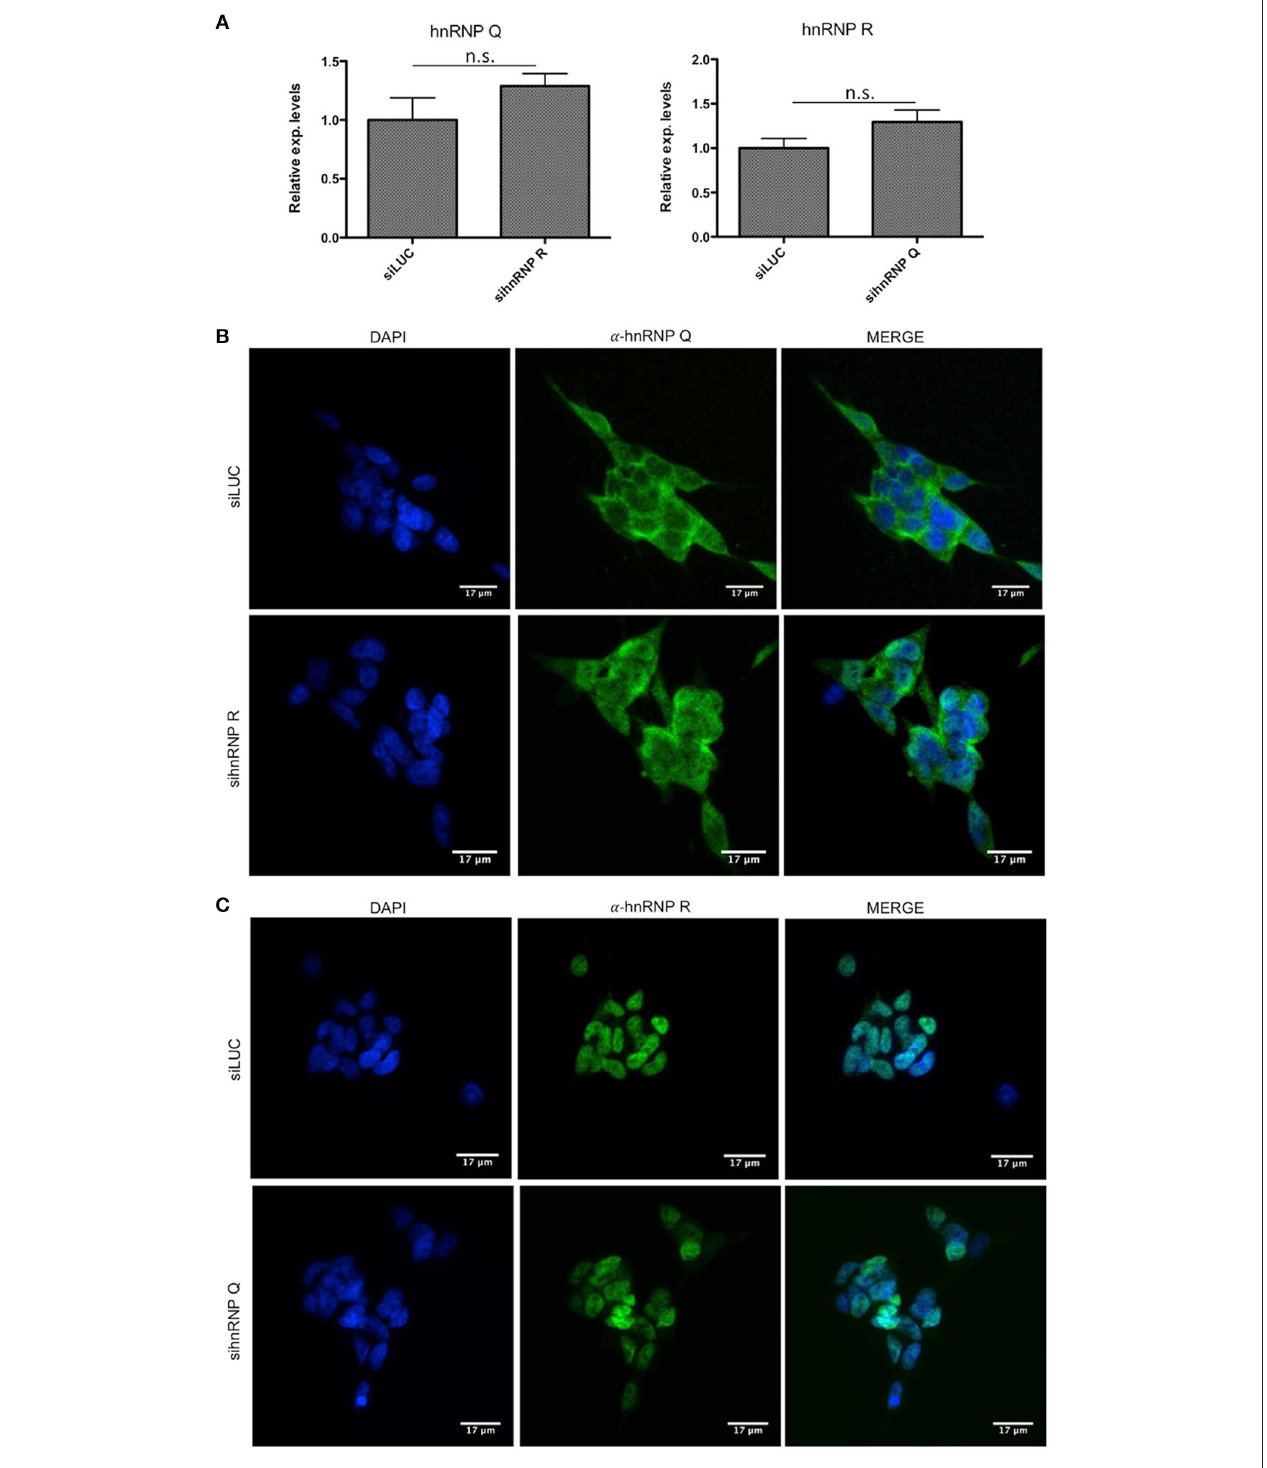
FIGURE 5 | mRNA levels and cellular localization of endogenous hnRNP Q and hnRNP R after knockdowns in SH-SY5Y cells. (A) Relative expression of hnRNP Q after siRNA against hnRNP R (sihnRNP R) and vice-versa. All the samples were compared to siLUC treated cells. Each bar reports mean ± standard error of three independent experiments. Statistical differences were evaluated using t-students (ns: not significant). (B) Immunofluorescence analysis of the endogenous human hnRNP Q (shown in green) in SH-SY5Y cells after siRNA treatment against hnRNP R. Nuclei were visualized using DAPI staining. Scale bars: 17 µ m. (C) Immunofluorescence analysis of the endogenous human hnRNP R (shown in green) in SH-SY5Y cells after siRNA treatment against hnRNP Q. Nuclei were visualized using DAPI staining. Scale bars: 17 µ m.